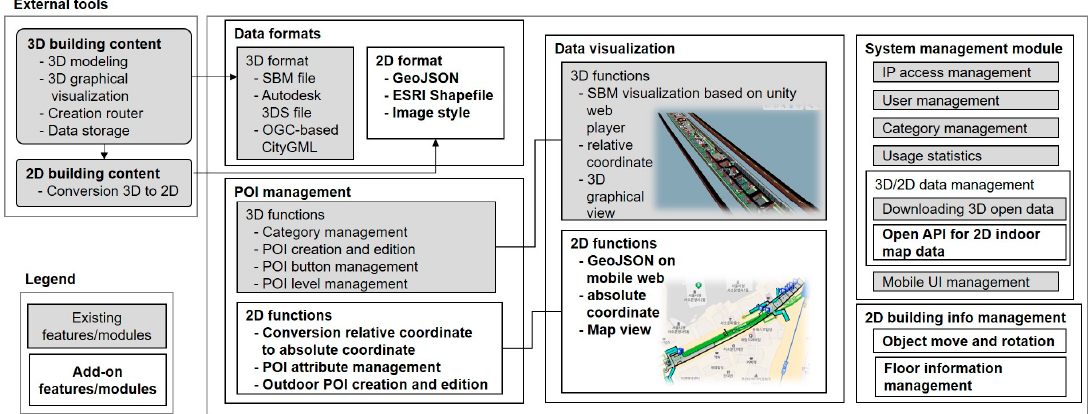
Figure 1. Main features of the indoor map service system. Add-on functions are shown as white boxes, and the gray shaded boxes represent existing functions for three-dimensional (3D)